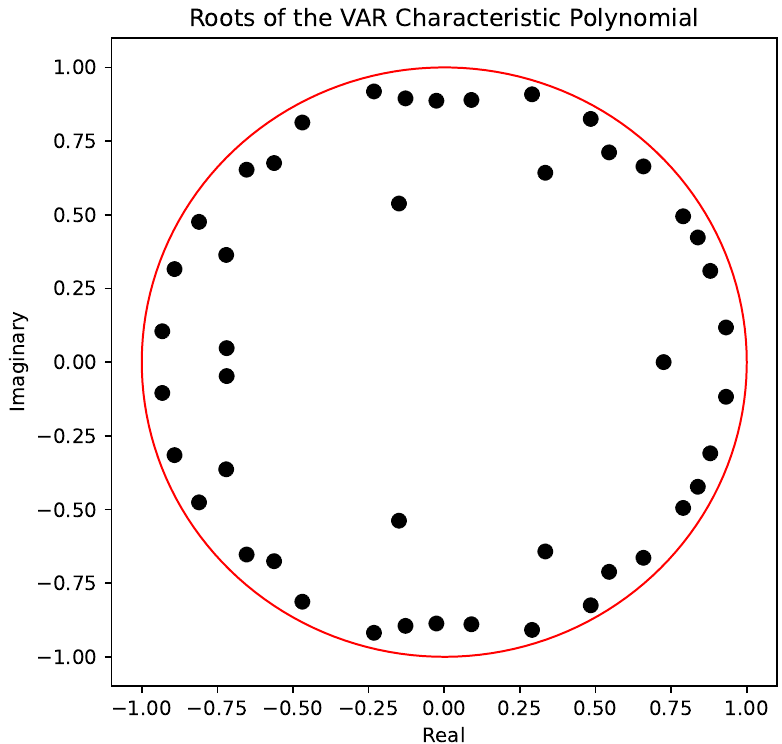
Figure A3. This plot shows the unit roots from the VAR characteristic polynomial. Since all unit roots lie inside the unit circle (in red), the VAR process is